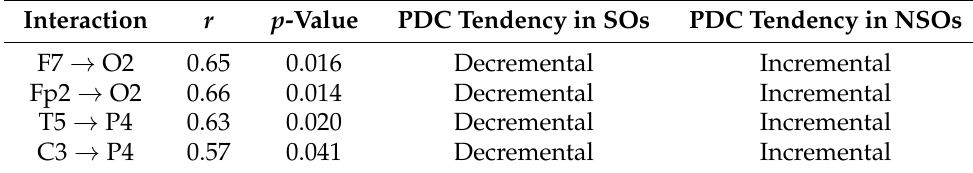
Table 3. Representative beta PDC interactions.